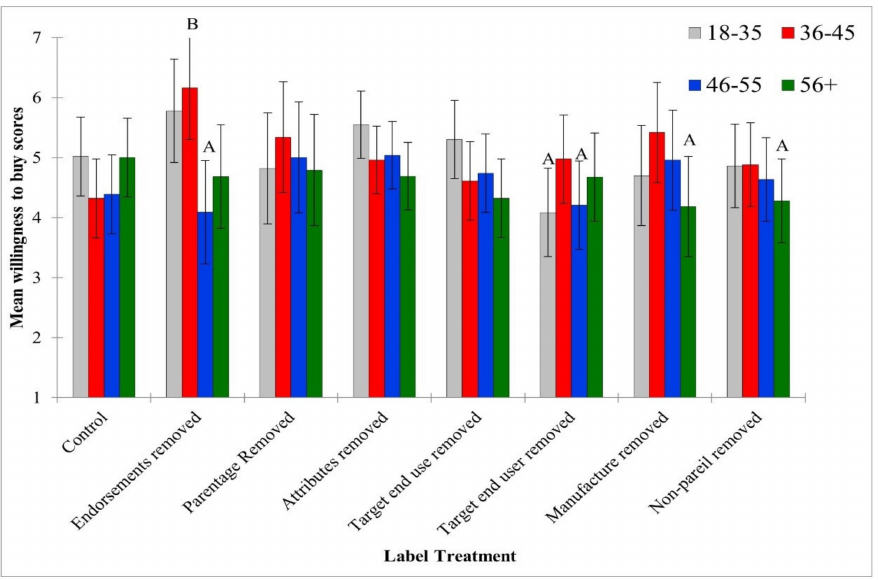
Figure 2. Label treatment × age interactions ( n = 572) +/ − SE for willingness to buy scores (7-point Likert scale) for the Prosecco-style label. Letters above bars represent significantly different groups (ANOVA followed by Tukey’s (HSD 0.05